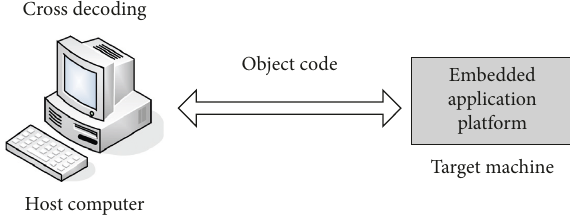
Figure 7: Tools for system. Figure 9 is a basic schematic diagram of sparse code